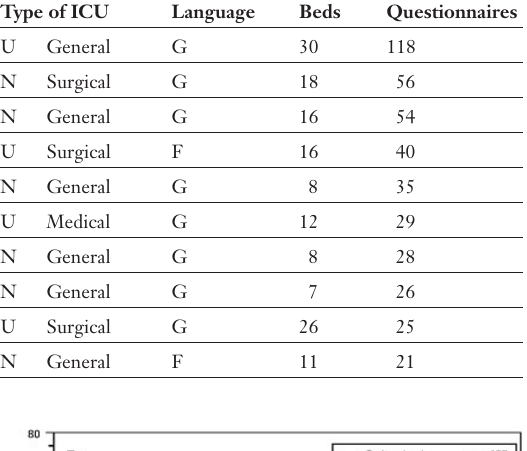
Characteristics of participating Intensive Care Units. Type of ICU: U = university hospital; N = non-university hospital; Principal language in the ICU: Location of ICU in the German (G) or French (F) part of Switzerland; Beds: num- ber of beds in the ICU; Questionnaires: Number of question- naires distributed to patients or